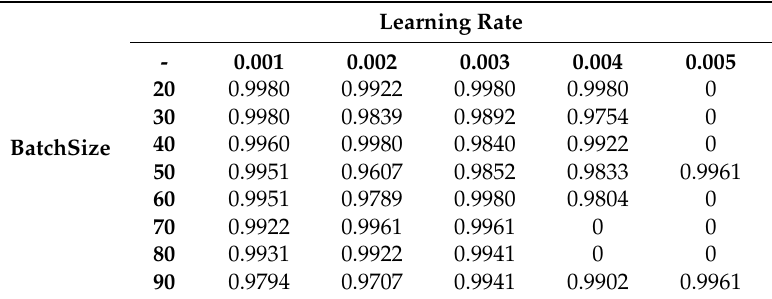
Table 3. Performance for different configuration (F